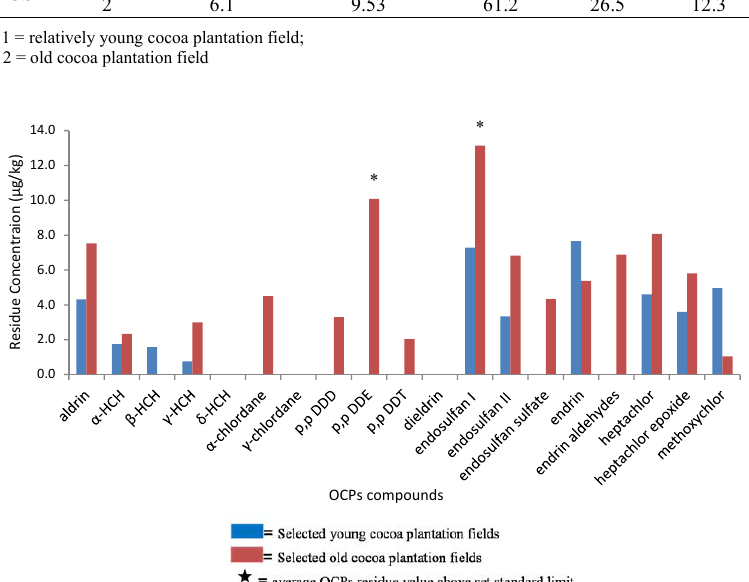
Fig. 2a : Organochlorine pesticides residue profile level in cocoa plantation soil of Edo State.